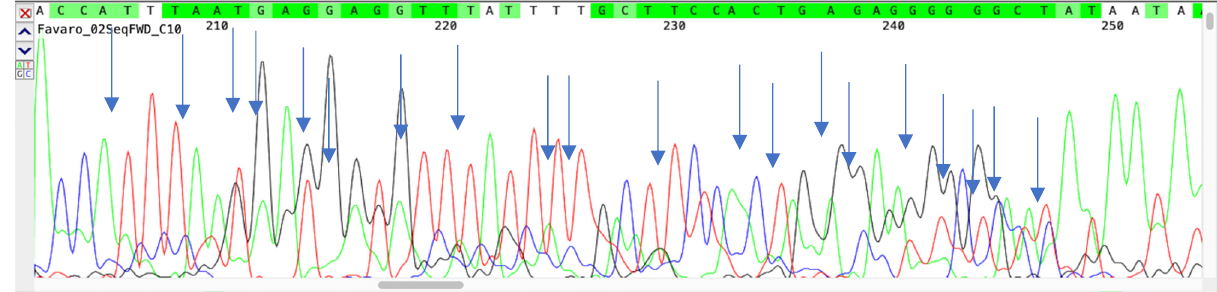
Figure 2. Electropherogram showing the sequence of samples in which more than one SARS-CoV-2 variant was present.